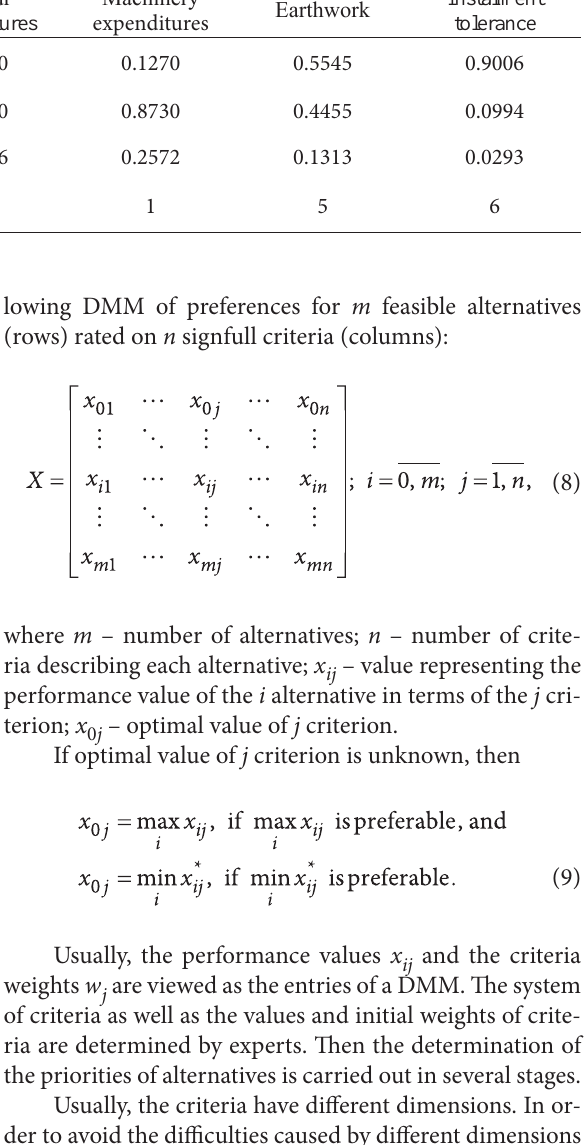
Table 2. Entropy level, j index change level and criteria weights